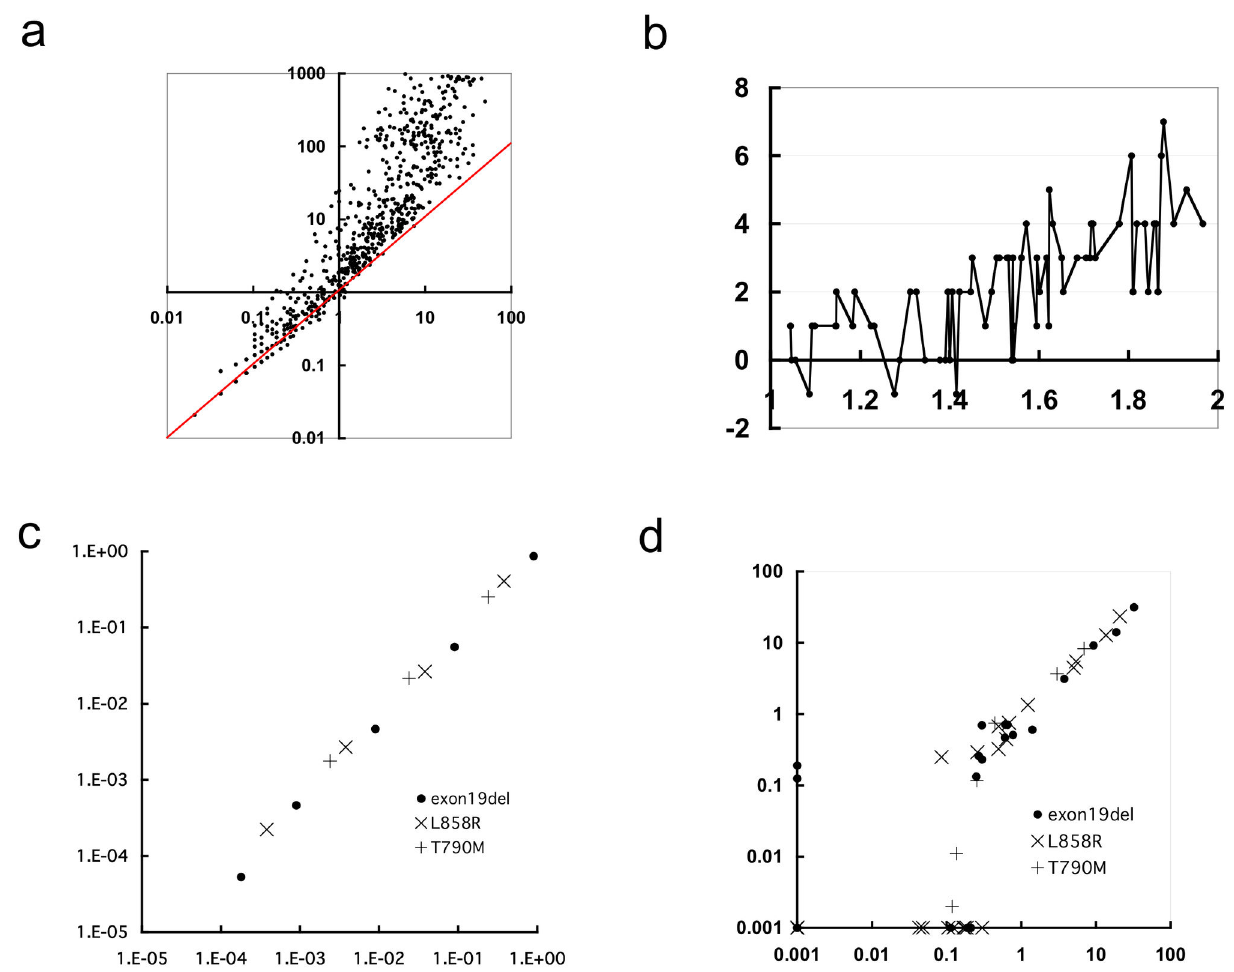
Figure 2. Characteristics of the mutation detection system. a, Relationship between the average and variance of the substitution error presented as the number per 100,000 reads. Horizontal axis, average; vertical axis, variance. The red line indicates where the average and variance are equal. b, Difference between thresholds calculated according to a negative binomial distribution and a Poisson distribution. The threshold is the minimum number of base changes in 100,000 reads meeting the level of statistical significance (p-0.01). Horizontal axis, variance/average ratio of the substitution read error; vertical axis, difference between thresholds. The types of substitutions whose variance/average ratio ranged from 1 to 2 are plotted. c, Accuracy of quantitation. Each data point represents the average of three assays. Horizontal axis, fraction of mutant alleles in artificial products; vertical axis, fraction of mutant alleles estimated from deep sequencing. d, Reproducibility of quantitation. Horizontal axis, base change rate in the first trial; vertical axis, base change rate in the second